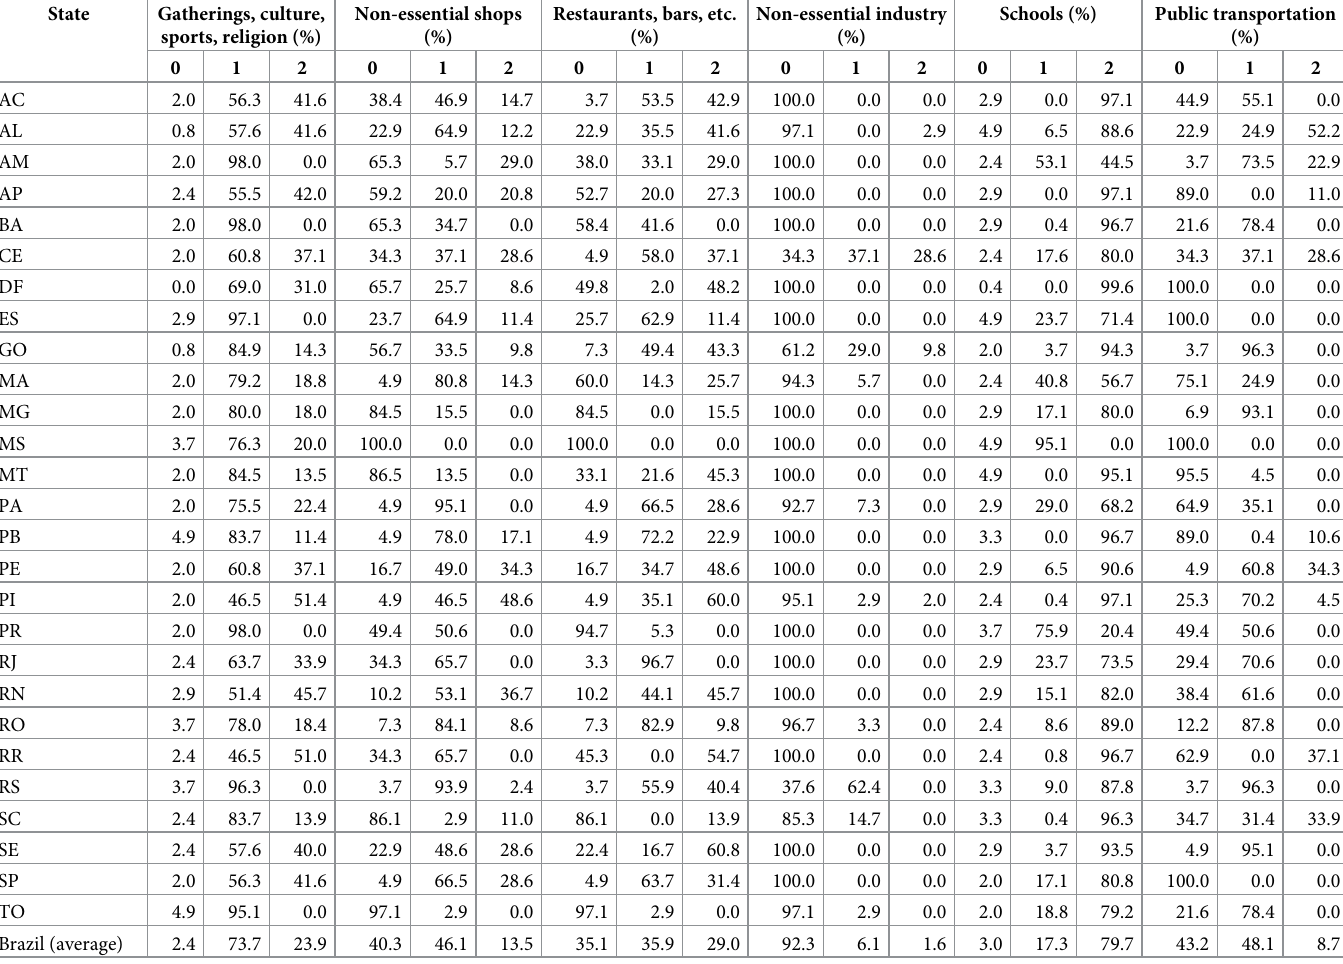
Table 2. Proportion of days in which social distancing rules were in force, by type of restriction and level of strictness (11 th March– 10 th November 2020), by state, Brazil, 2020. State Gatherings, culture, sports, religion